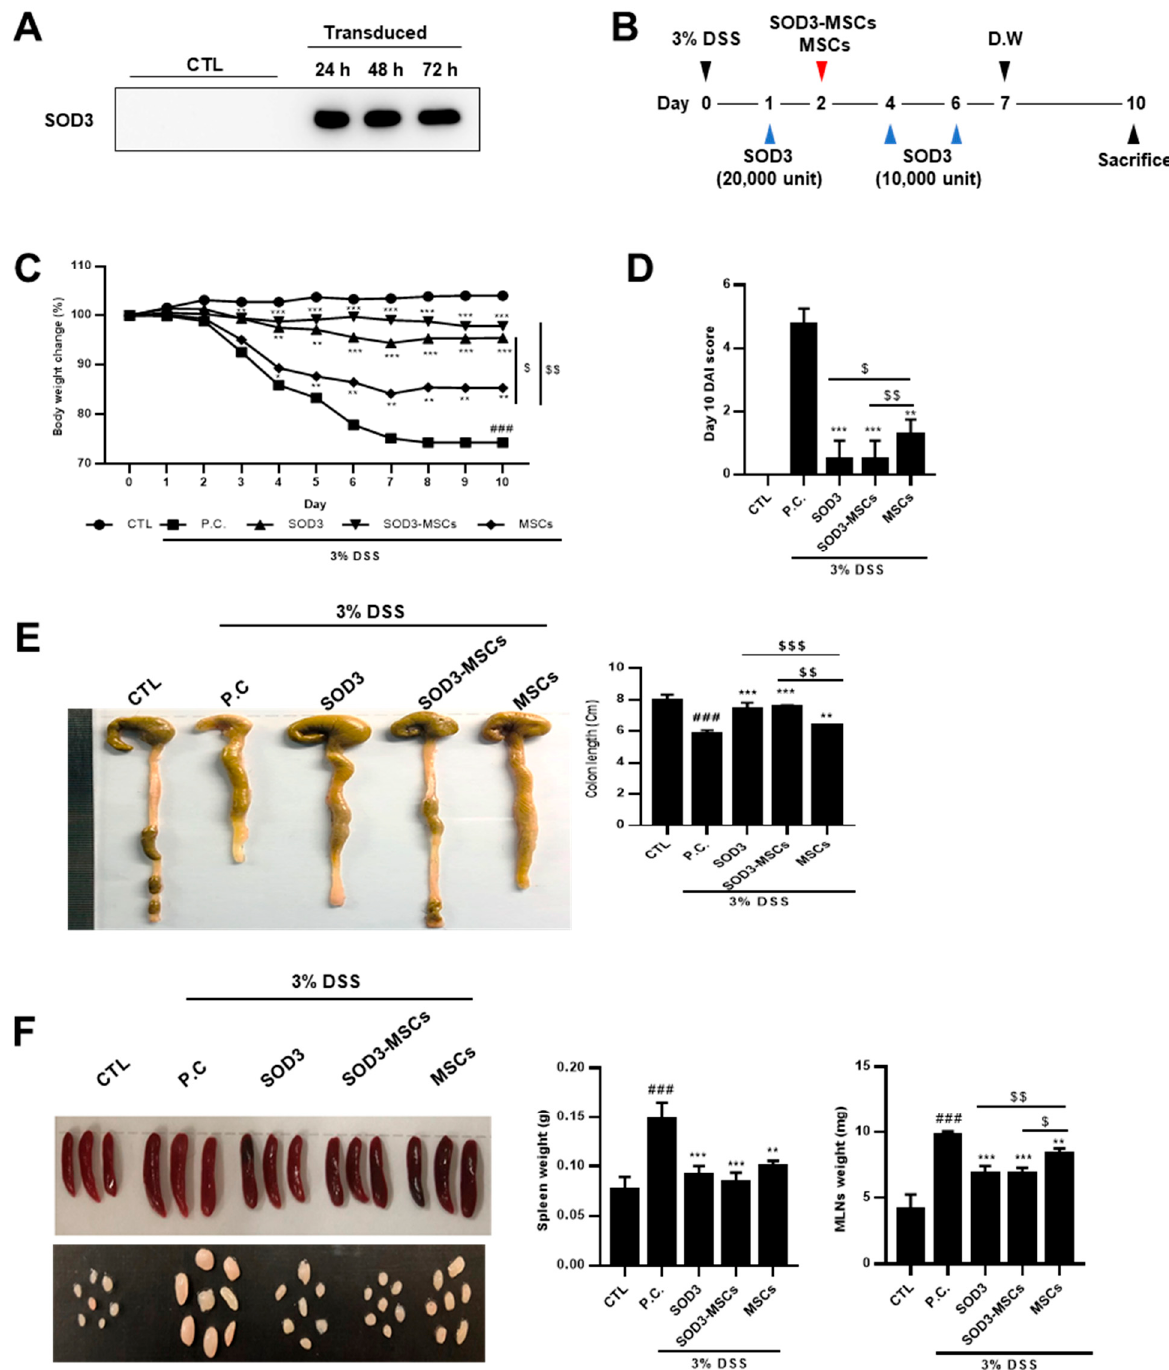
Figure 3. Administration of SOD3 protein and SOD3-MSC attenuate symptoms of murine colitis. ( A ) SOD3-transduced MSCs were confirmed for SOD3 secretion by performing western blotting using cell culture supernatant. ( B ) Timeline for in vivo colitis induction and SOD3 or SOD3-MSC administration. Five mice per group were used. SOD3 or SOD3-MSCs were i.p. injected on the designated day. ( C ) Body weight loss of each group was measured and shown as percentage loss. ( D ) Disease activity index for colitis severity on day 10 was scored. ( E ) The mice were sacrificed on day 10 and the length of colon was measured. ( F ) The weight of the spleen and MLNs was measured. D.W. = distilled water, ### p < 0.001 (CTL vs. P.C), * p < 0.05, ** p < 0.01, *** p < 0.001 (P.C vs. SOD3, SOD3-MSCs and MSCs), $ p < 0.05, $$ p < 0.01, $$$ p < 0.001 (SOD3, SOD3-MSCs vs. MSCs).